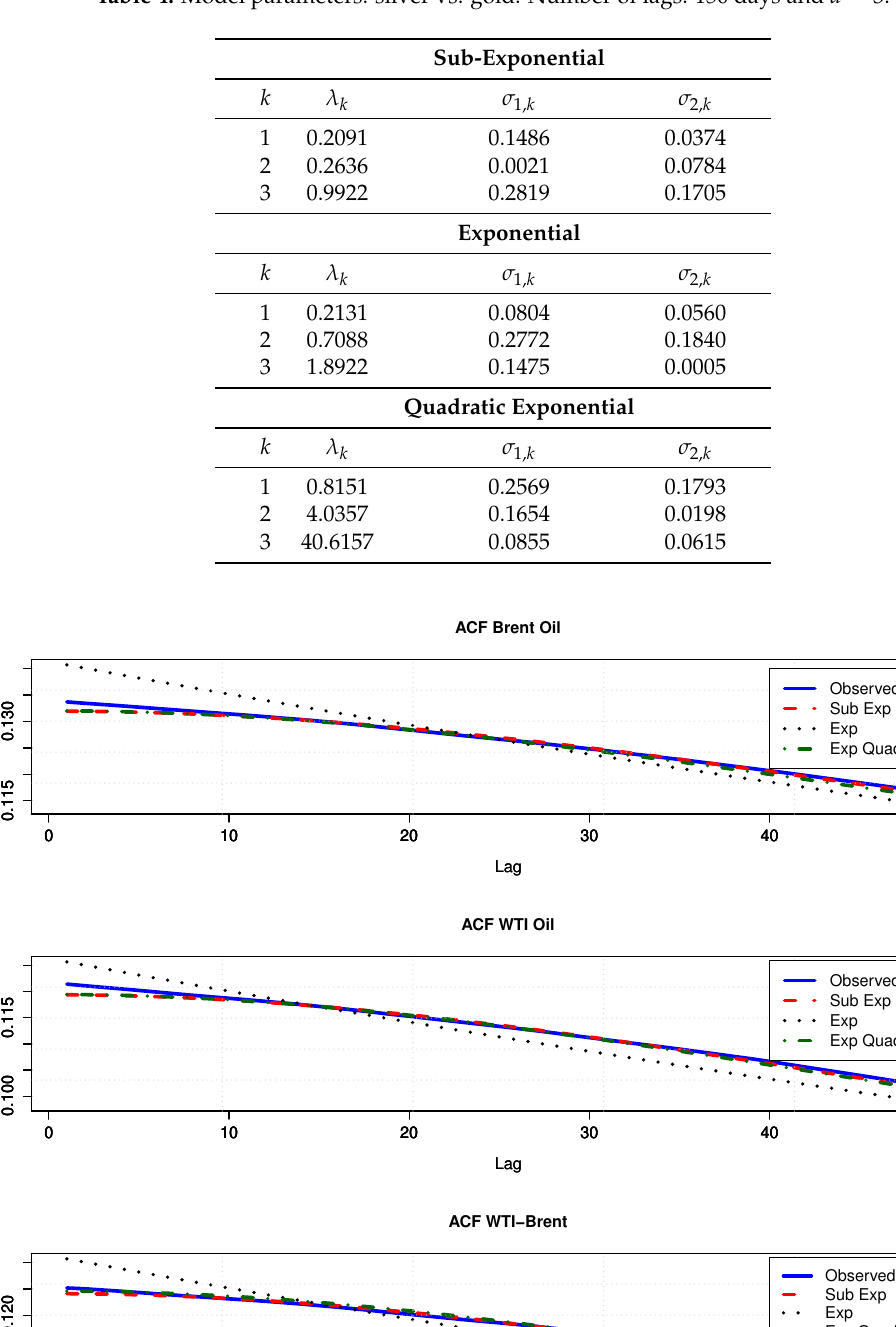
Table 4. Model parameters: silver vs. gold. Number of lags: 150 days and d = 3.